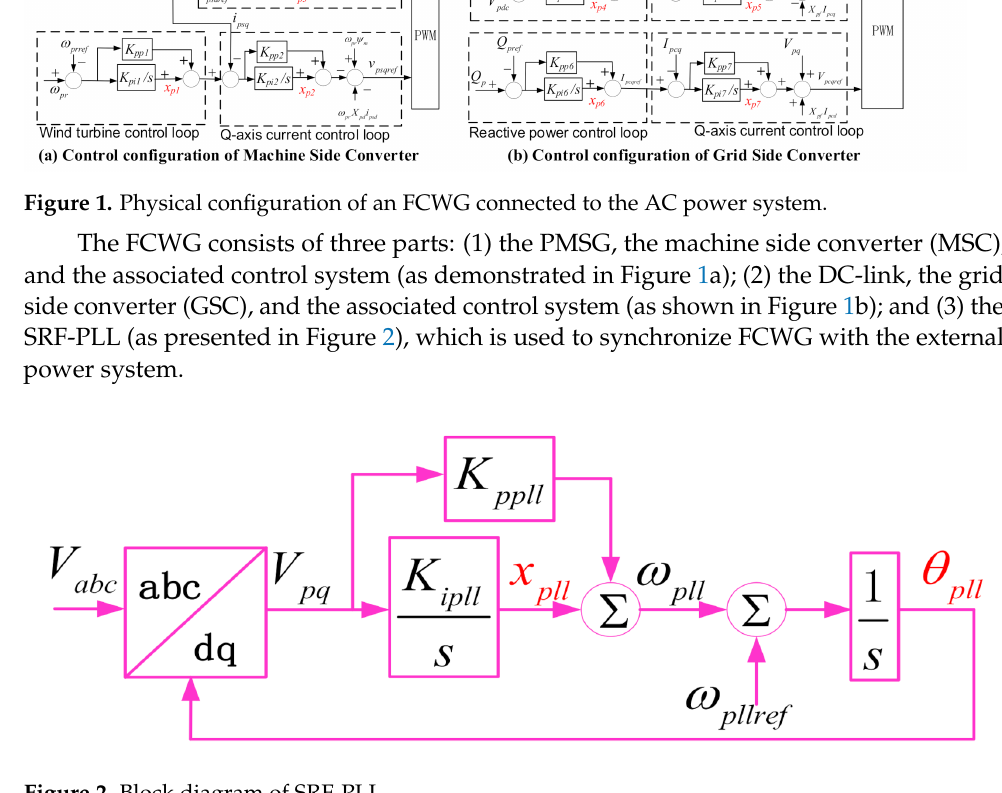
Figure 2. Block diagram of